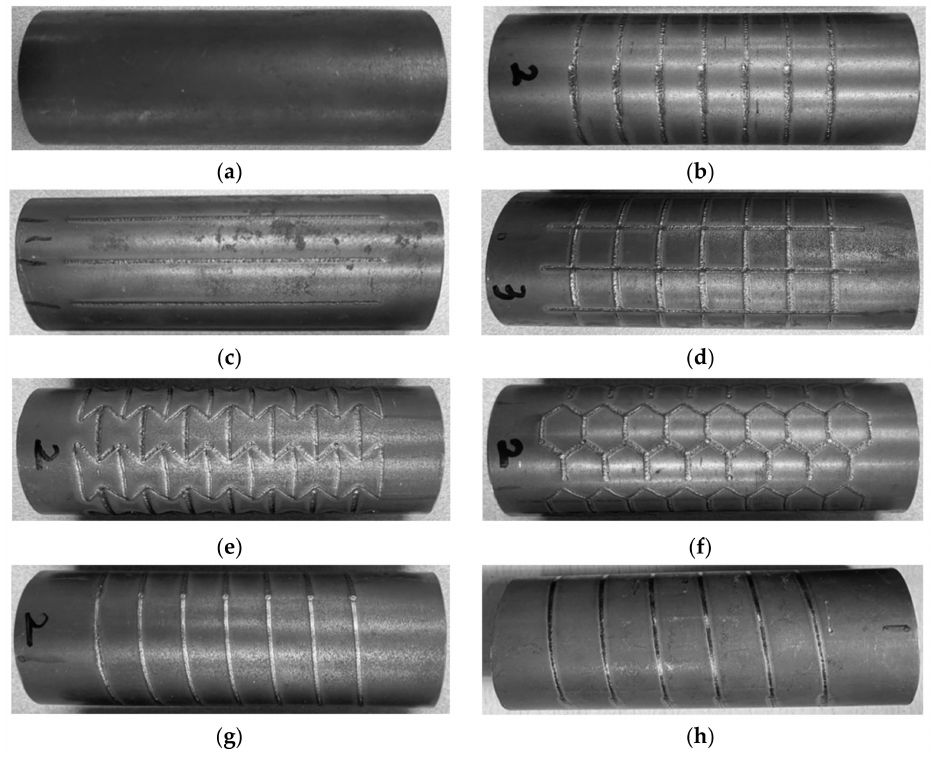
Figure 2. Laser-irradiated specimens with patterning of: ( a ) initial; ( b ) 0 ◦ ; ( c ) 90 ◦ ; ( d ) grid; ( e ) auxetic; ( f ) honeycomb; ( g ) helical with pitch of 10 mm; ( h ) helical with pitch of 12.5